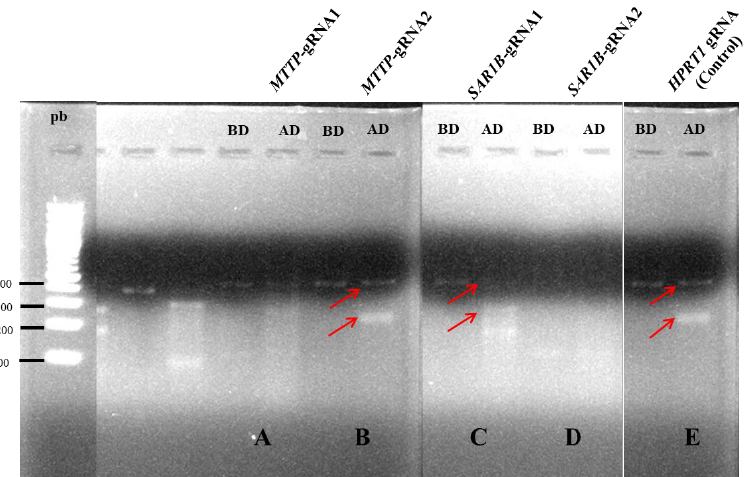
Figure 1. Confirmation of gRNA efficiency later used for transfection and silencing of MTTP or SAR1B by CRISPR/Cas9. Amplification products detected on 1% E-gel EX agarose of genomic DNA extracted from Caco-2/TC7 cell line transfected with ( A ) gRNA1 targeting MTTP , ( B ) gRNA2 targeting MTTP , ( C ) gRNA1 targeting SAR1B , ( D ) gRNA2 targeting SAR1B and ( E ) gRNA targeting HPRT1, used as a control gene, before ( B , D ) the enzymatic digestion efficiency test and after ( A , D ) the enzymatic digestion efficiency test. This method detects locus-specific DNA double-strand breaks formation by direct polymerase chain reaction (PCR) amplification and endonuclease activity that specifically cuts at hetero-duplex mismatches. Only mutated DNA could be targeted and cut by the Digestion Enzyme, as evidenced by the presence of two bands, indicated by red arrows, with sizes congruent with the distance between Cas9 cutting sites. 3.2. MTP and Sar1b Proteins Are Not Expressed in KO Clones We obtained 47 living clones transfected with the MTTP -gRNA and 57 living clones transfected with the SAR1B -gRNA. DNA sequencing shows two kinds of results: (1) fully determined sequences with no mutation or (2) several overlapping sequences (Figure 2a,b). The presence of several overlapping sequences is likely due to the fact that Caco- 2’s modal chromosome number is 96, occurring at 16%, with polyploidy at 3.2%.